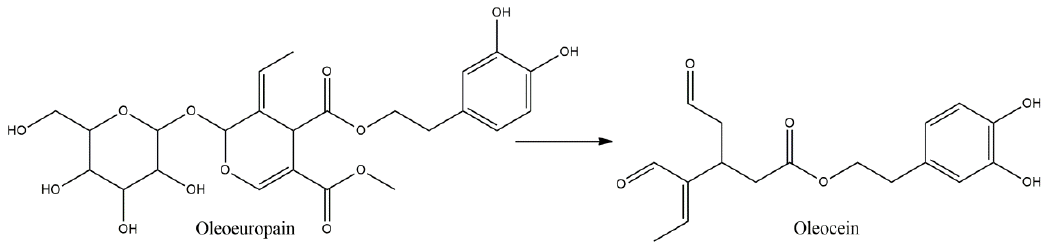
Figure 3. Oleuropein and its secoiridoid derivative, oleacein.